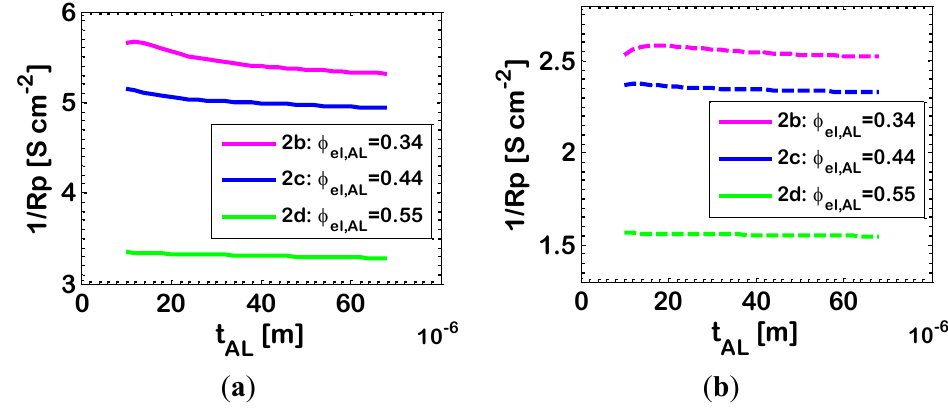
Figure 5. Effect of AL thickness on the 1/ R Varying parameter: Ni volumetric fraction in the AL (ϕ ( a ) T = 1073 K; and ( b ) T = 973